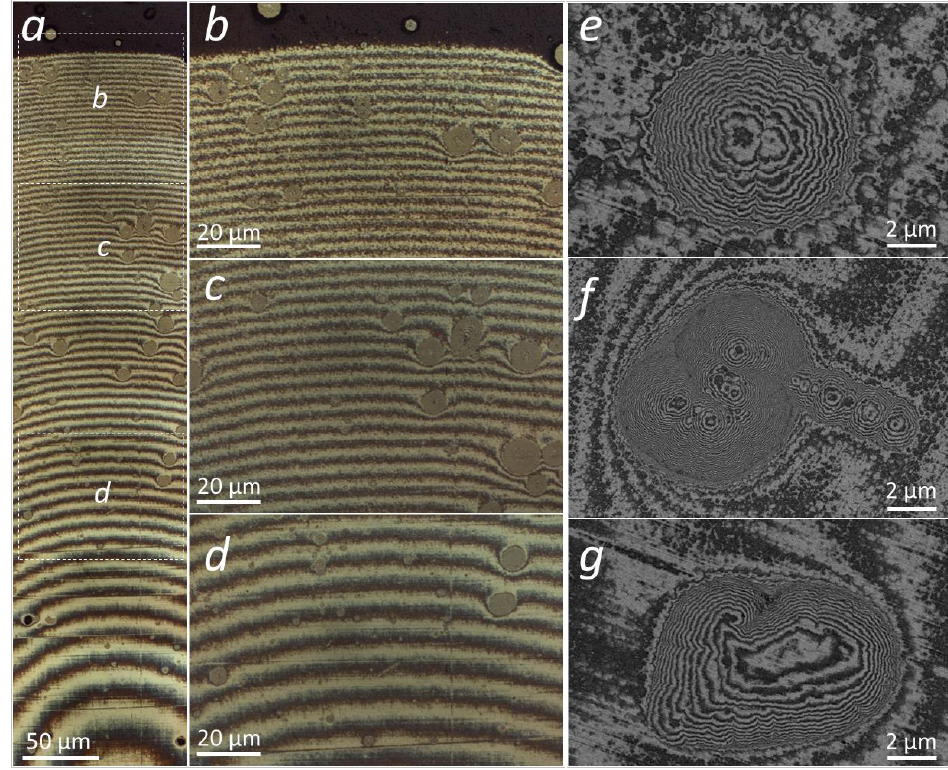
Figure 15. Optical microscopy images at lower ( a ) and higher ( b – d ) magnifications of a low-angle cross-section of the NL-TiAlN/CrN coating, prepared by the ball cratering technique. SEM images of the ground section of selected nodular defects ( e – g ) reveal their internal structure due to the complex geometry of seed particles.